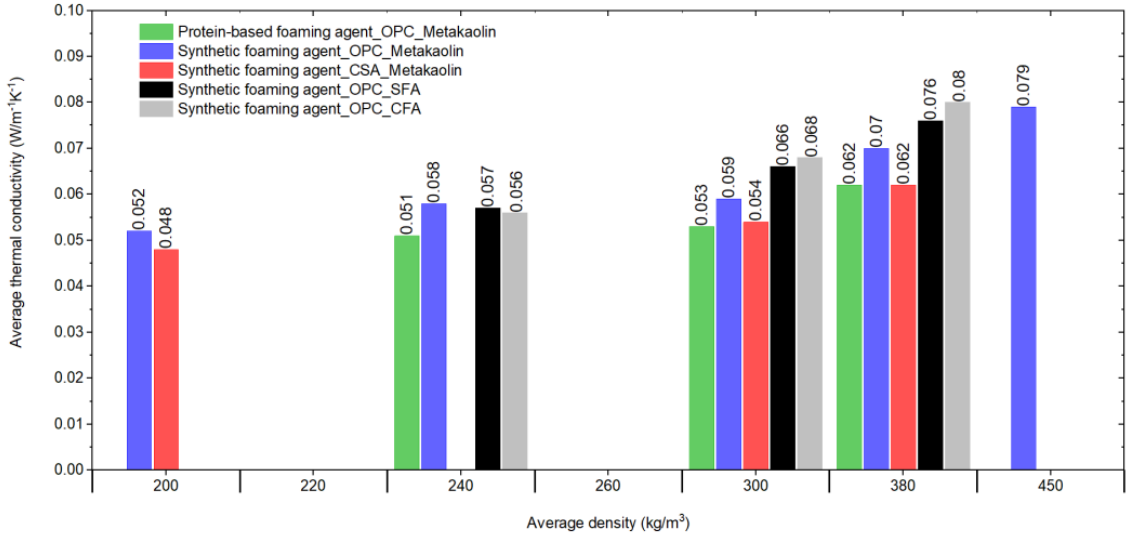
Figure 17. Average thermal conductivity for all tested foam concrete.